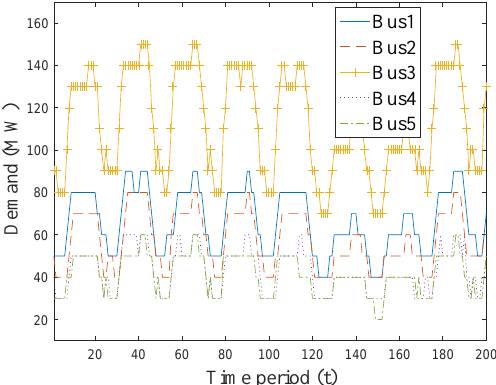
Figure 2. Load profile in the test